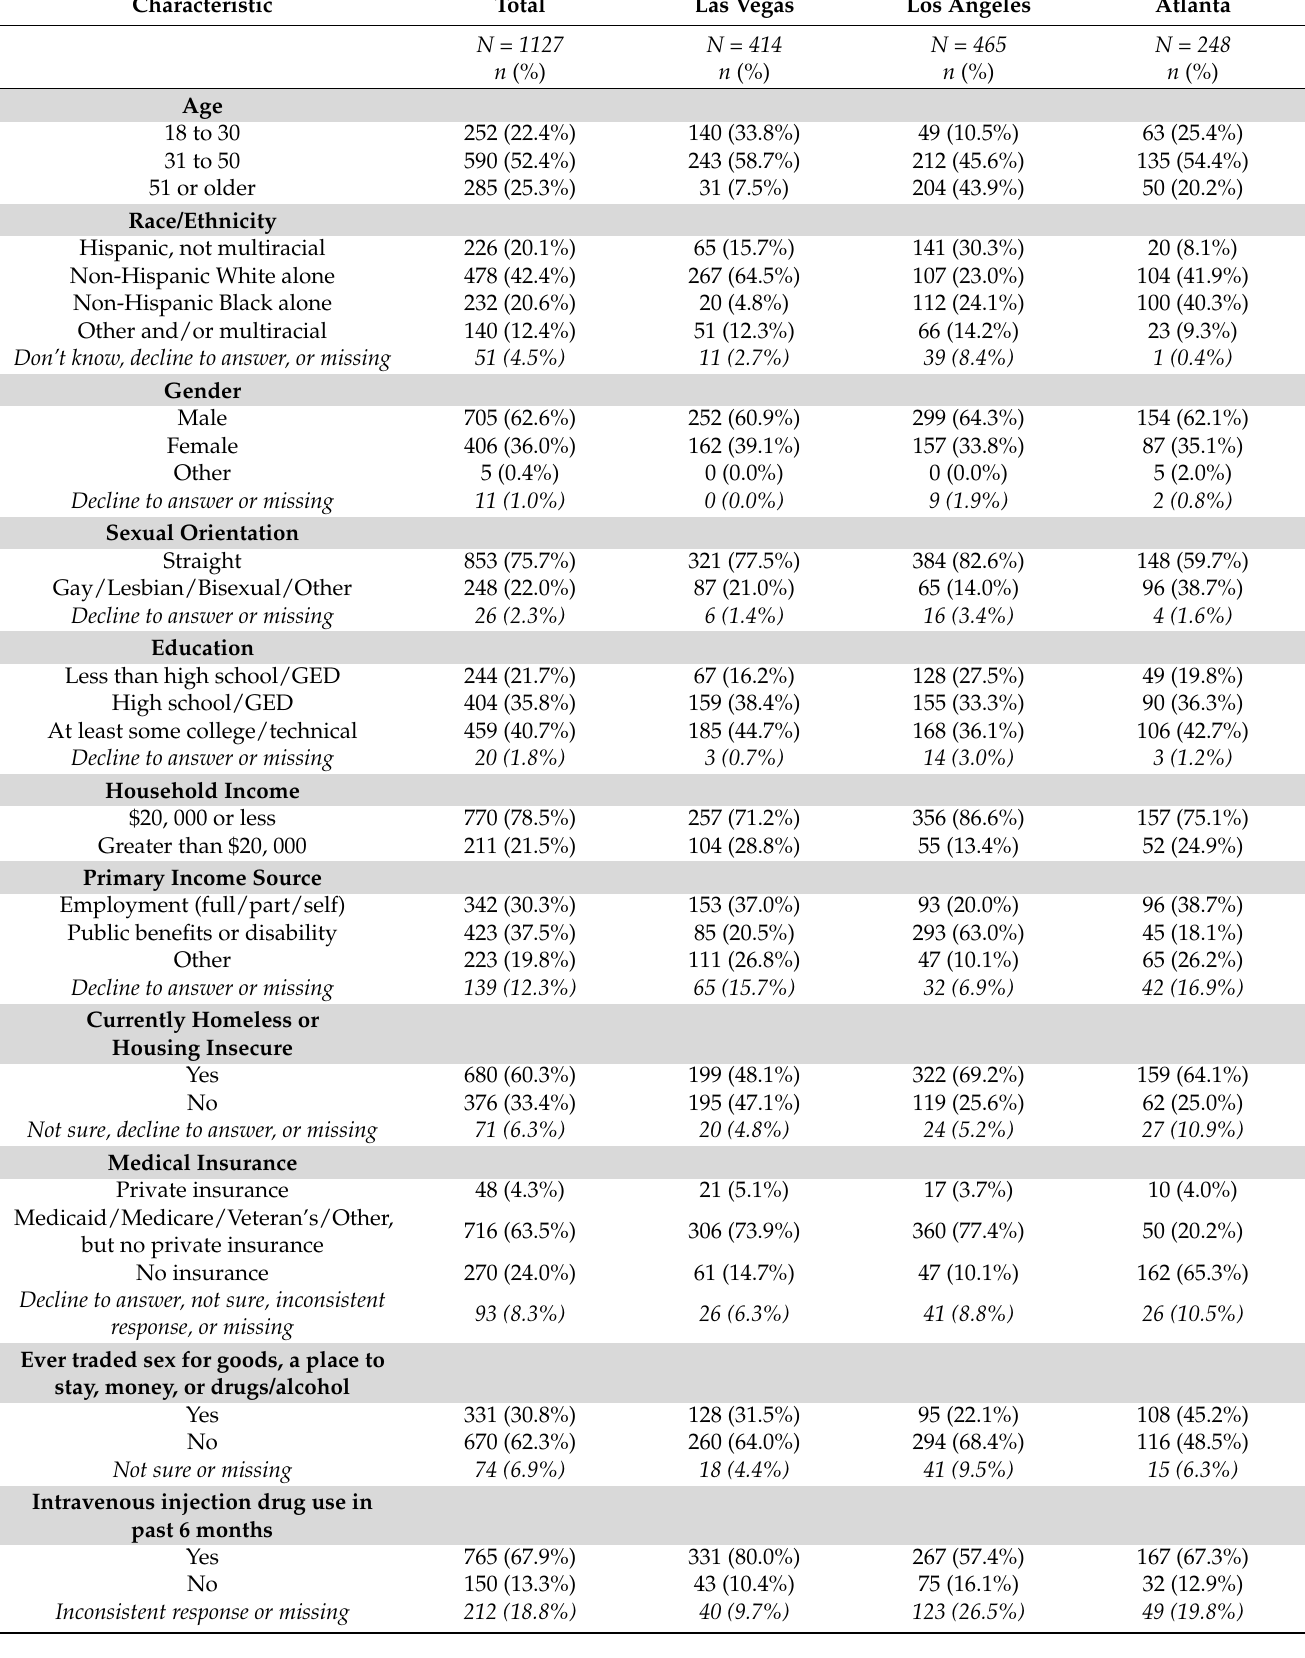
Table 1. Sociodemographic characteristics of participants, by recruitment